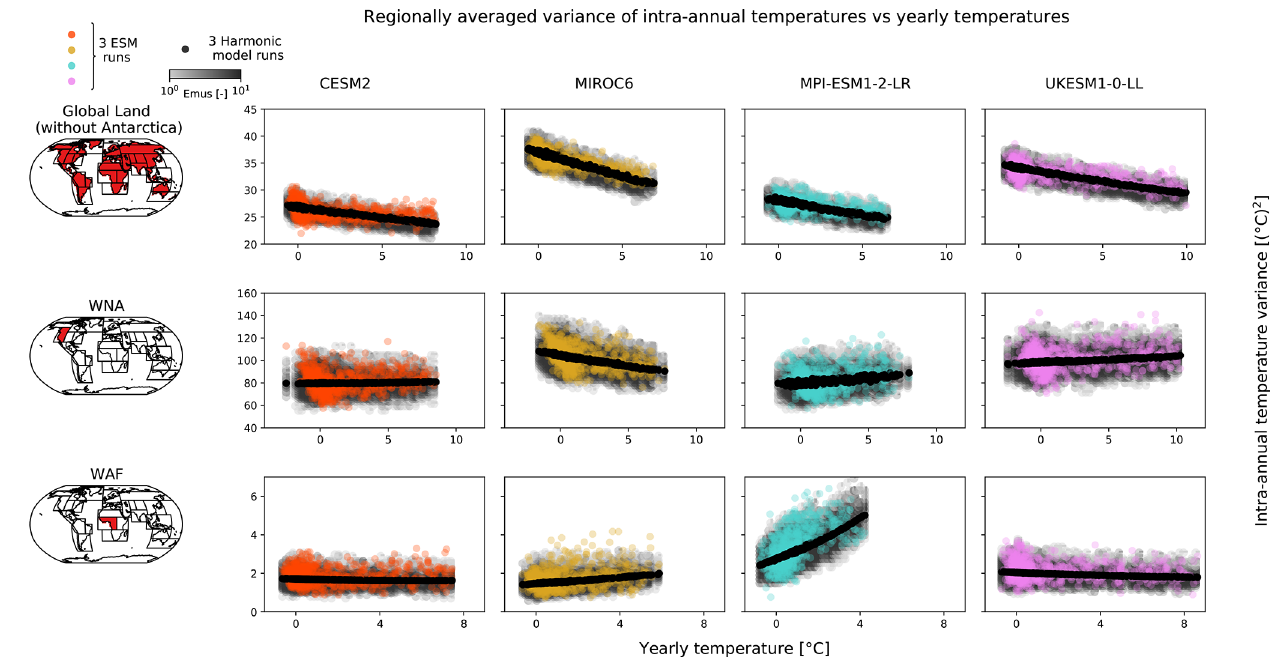
Figure 4. Regionally averaged variance of intra-annual temperatures (i.e. variance of each year’s monthly temperatures around the yearly mean) scatterplotted against yearly temperature (rows) for four example ESMs (columns).Three ESM ensemble runs (coloured), their re- spective harmonic-model results (black), and 50 full emulations for each of the three patterns (grey colour scale) are plotted. Temperature values are taken as anomalies with respect to the annual climatological mean over the reference period of 1870–1899. Each dot represents the temperature variance calculated from the monthly values for 1 individual year. The regions are from top to bottom: global land without Antarctica, western North America (WNA), and West Africa